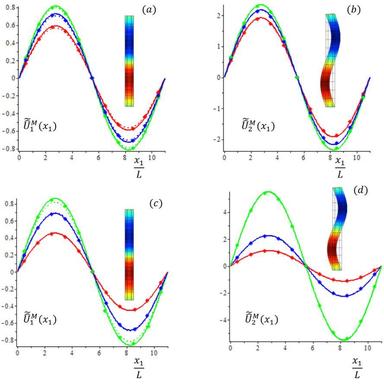
Dimensionless transformed macro-displacement component Uˆ M α (x1 ) induced by transformed body force bˆα (x1 ) with α = 1, 2: (a) Uˆ M 1 (x1 ); (b) Uˆ M 2 (x1 ); (c) Uˆ M 1 (x1 ); (d) Uˆ M 2 (x1 ). For (a) and (b) the curves are obtained with different relaxation times related to phase 1 and phase 2. The red curves are obtained by assuming relaxation times as τ 1 ς = 1, τ 2 ς = 2, the blue curves as τ 1 ς = 2, τ 2 ς = 4 and the green ones as τ 1 ς = 10, τ 2 ς = 20, with rρ = rE = 10, sς = −0.5, ν˜1 = ν˜2